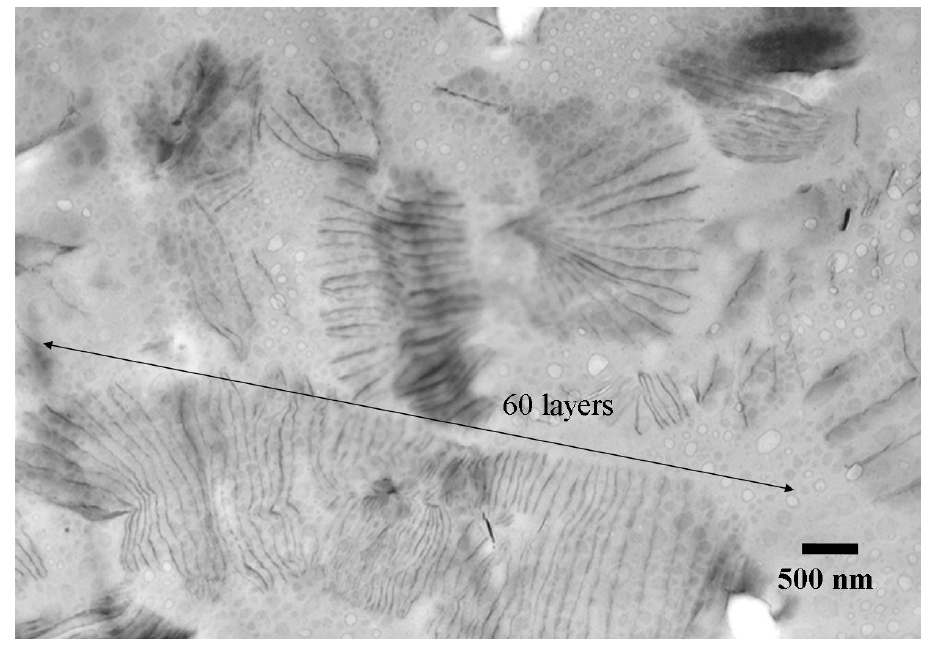
Figure 7. TEM of 3 wt % Mica/POP2000 initiated epoxy self-curing material (reprinted with permission from reference